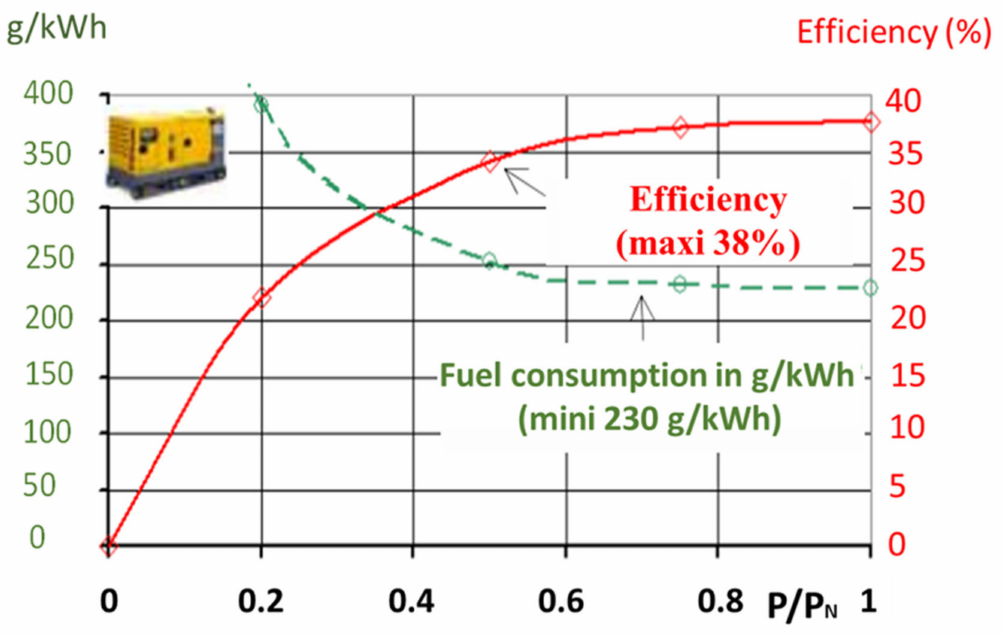
Figure 10. Characteristics (efficiency and consumption as a function of the load rate) of a diesel generator